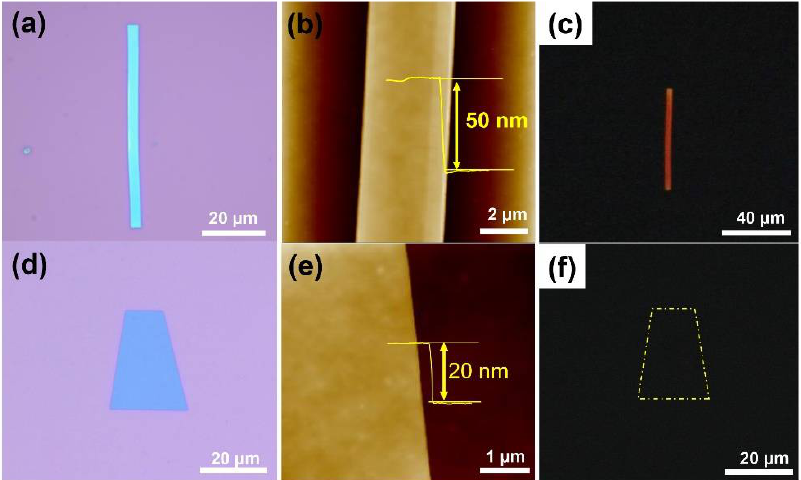
Figure 1. Morphological characterization of the pentacene crystal grown by MAS method. ( a , d ) Mi- croscope images of nanoribbon and nanosheet crystals grown at the temperatures of 180 °C and 260 °C, respectively; scale bar: 20 μm. ( b , e ) The corresponding AFM images; the inset shows the thick- ness; scale bars: 2 μm and 1 μm. ( c , f ) The corresponding PL images, λ ex = 365 nm, scale bars: 40 μm and 20 μm.